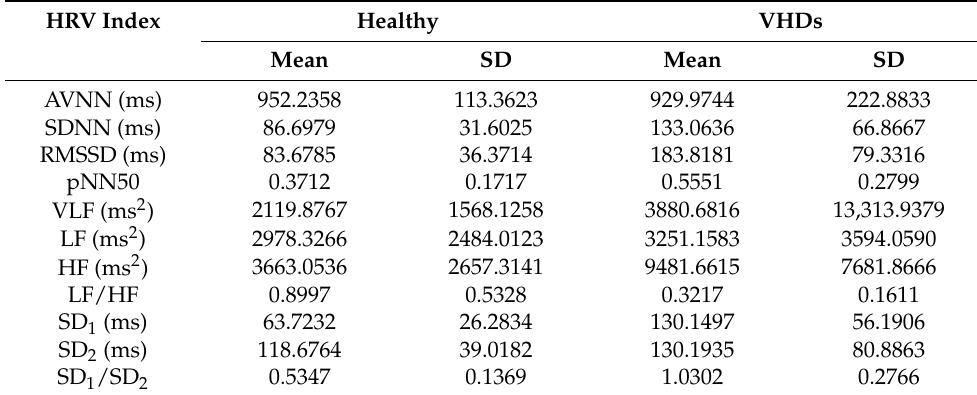
Table 4. HRV indices derived from GCG signals from both datasets.